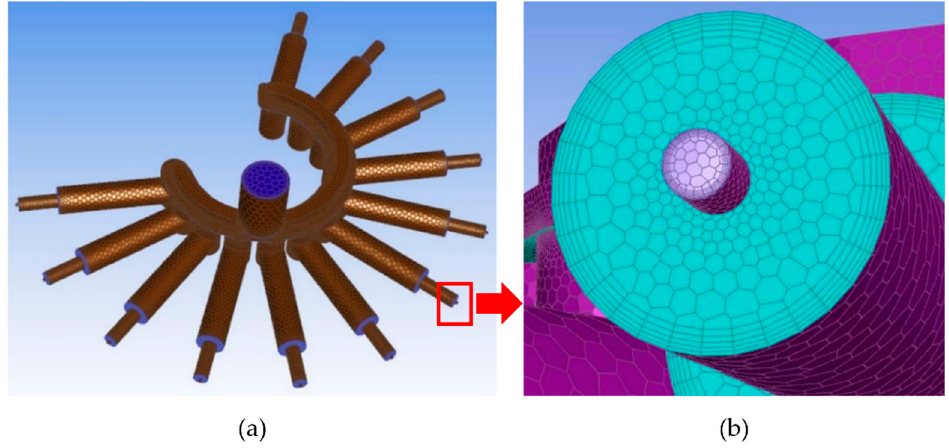
Figure 7. Fluid domain meshing: ( a ) overall meshing diagram; ( b ) meshing diagram for seed-sucking hole.